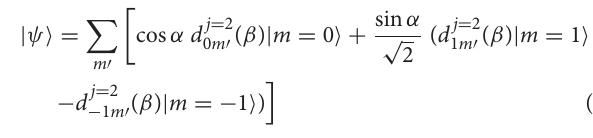
FIGURE 3 | The effect of the coherent interfering terms given in Equation (6) on the scattering images of rotationally relaxed HD ( v and XSARP axis orientations. The scattering images including the coherence terms are given on the left side, while those without are given on the right side. Clearly, the m state superposition breaks the ϕ